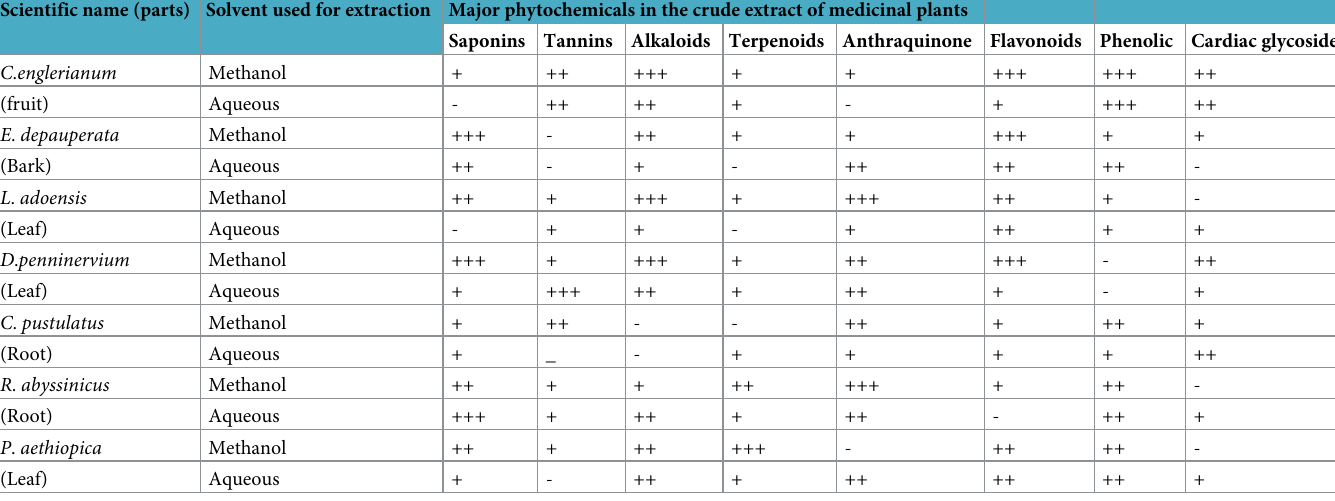
Table 4. Preliminary phytochemical screening of some traditional medicinal plants collected from Bale Zone. Scientific name (parts) Solvent used for extraction Major phytochemicals in the crude extract of medicinal